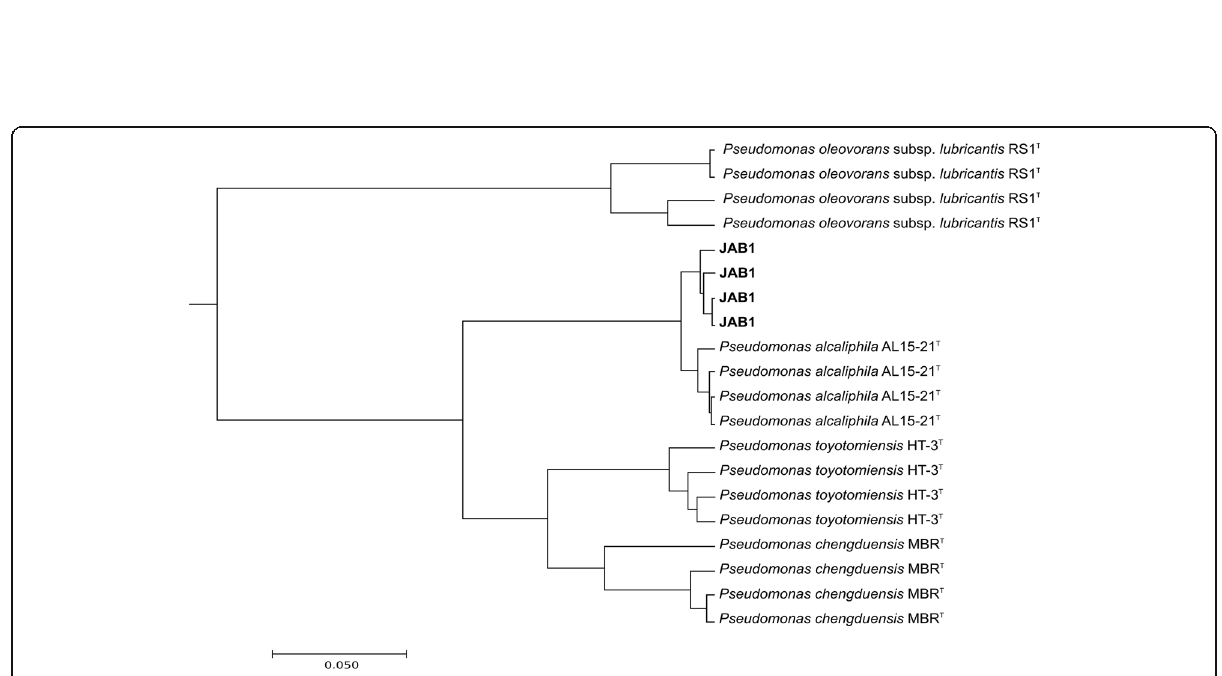
Fig. 3 Clustering of MS spectra of strain JAB1 and related pseudomonads